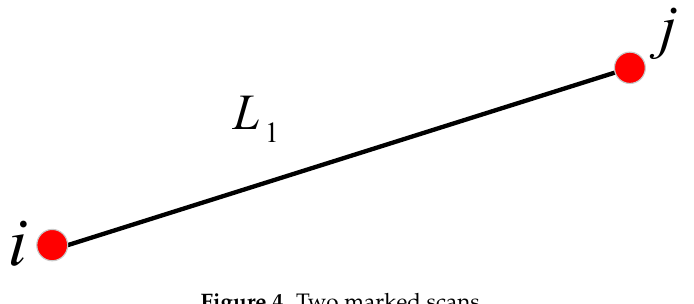
Figure 4. Two marked scans.